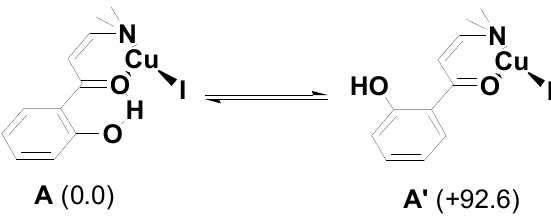
Scheme 4. LCuI complex formation. Values in parentheses are free energies in kJ/mol.